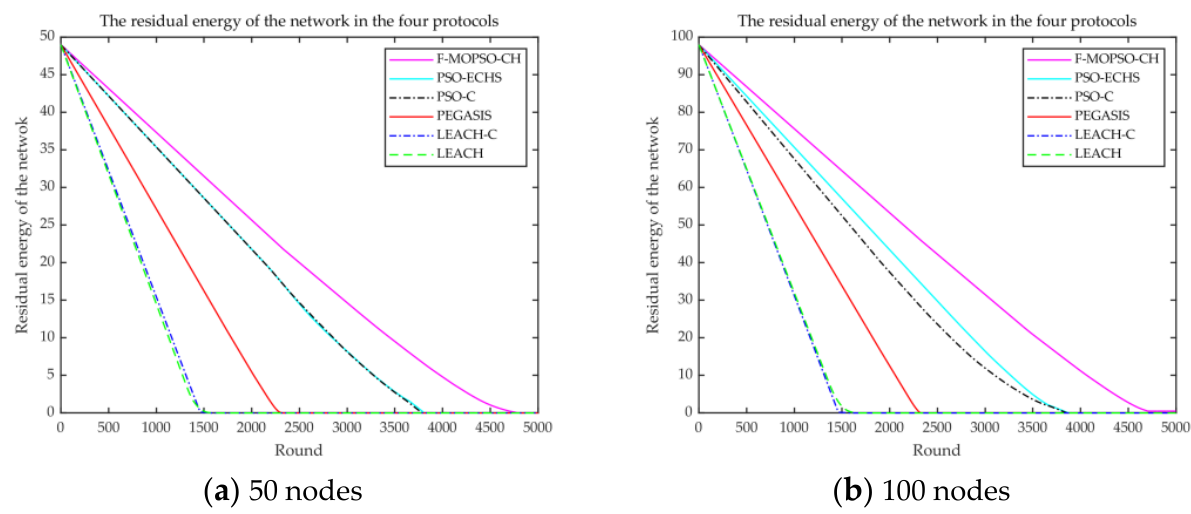
Figure 10. Comparison of the network energy consumption for ( a ) 50 and ( b ) 100 nodes.